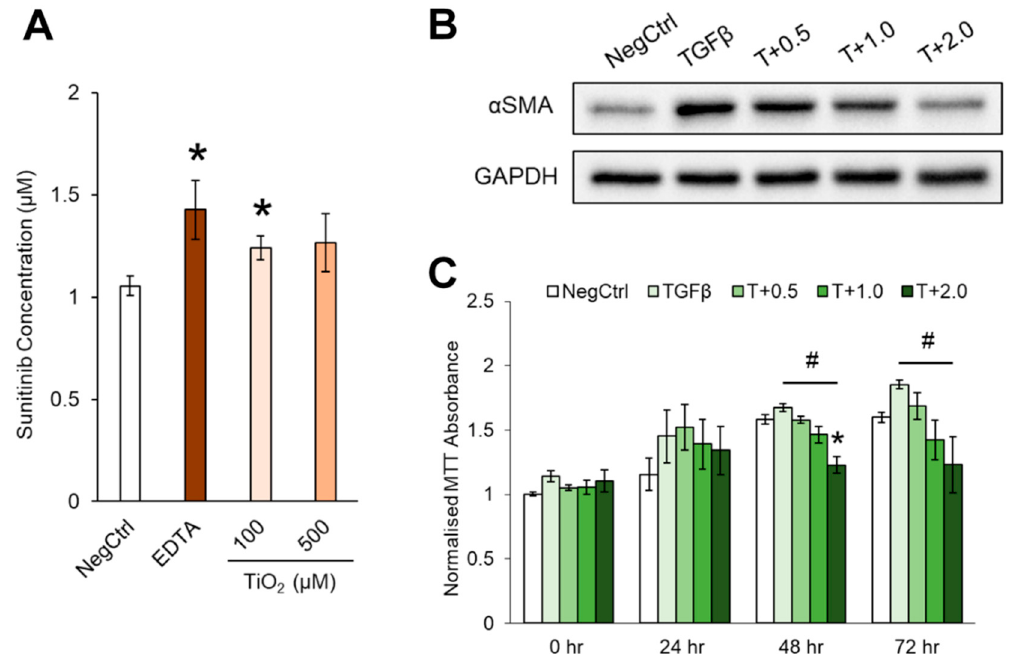
Figure 6. TiO 2 NP-induced leakiness promoted Sunitinib transport across the HHSEC barrier. ( A ) Endothelial leakiness from HHSECs treated with TiO 2 NPs significantly increased the transport of Sunitinib across the endothelial barrier, compared to the non-treated control (NegCtrl). EDTA was used as a positive control. Data represent mean ± SE ( n = 3), one-tail equal variance Student’s t -test, * p < 0.05. ( B ) The increase in Sunitinib concentration was found to reduce pro-fibrotic marker α -SMA in transforming growth factor-beta 1 (TGF- β 1)-activated hepatic stellate cells LX2 after 24 h treatment. Untreated LX2 cells were used as the negative control (NegCtrl). ( C ) Increased concentrations of Sunitinib were also found to reduce the viability of TGF- β 1-activated LX2 cells up to 72 h. Data represents mean ± SE ( n = 3), one-way ANOVA with Tukey HSD test, * p < 0.05 denotes significance against non-treated control at respective timepoint, # p < 0.05 denotes significance against TGF- β 1 treated control.